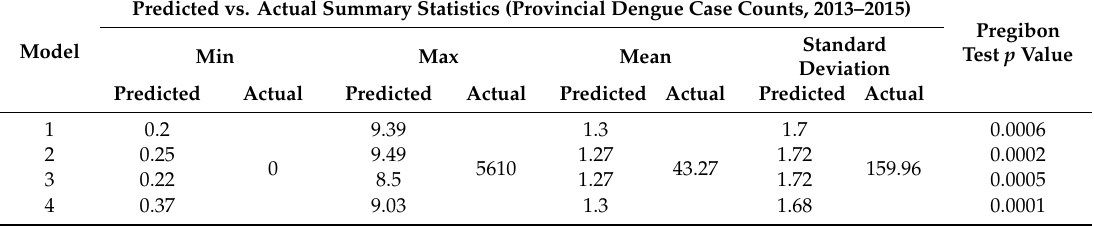
Table 3. Summary of four final candidate model predicted case counts and Pregibon’s statistic.